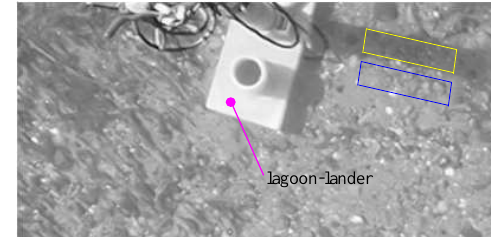
Figure 3. Pixel extraction for cloud-shadow algorithm. dp (yellow box), bp (blue